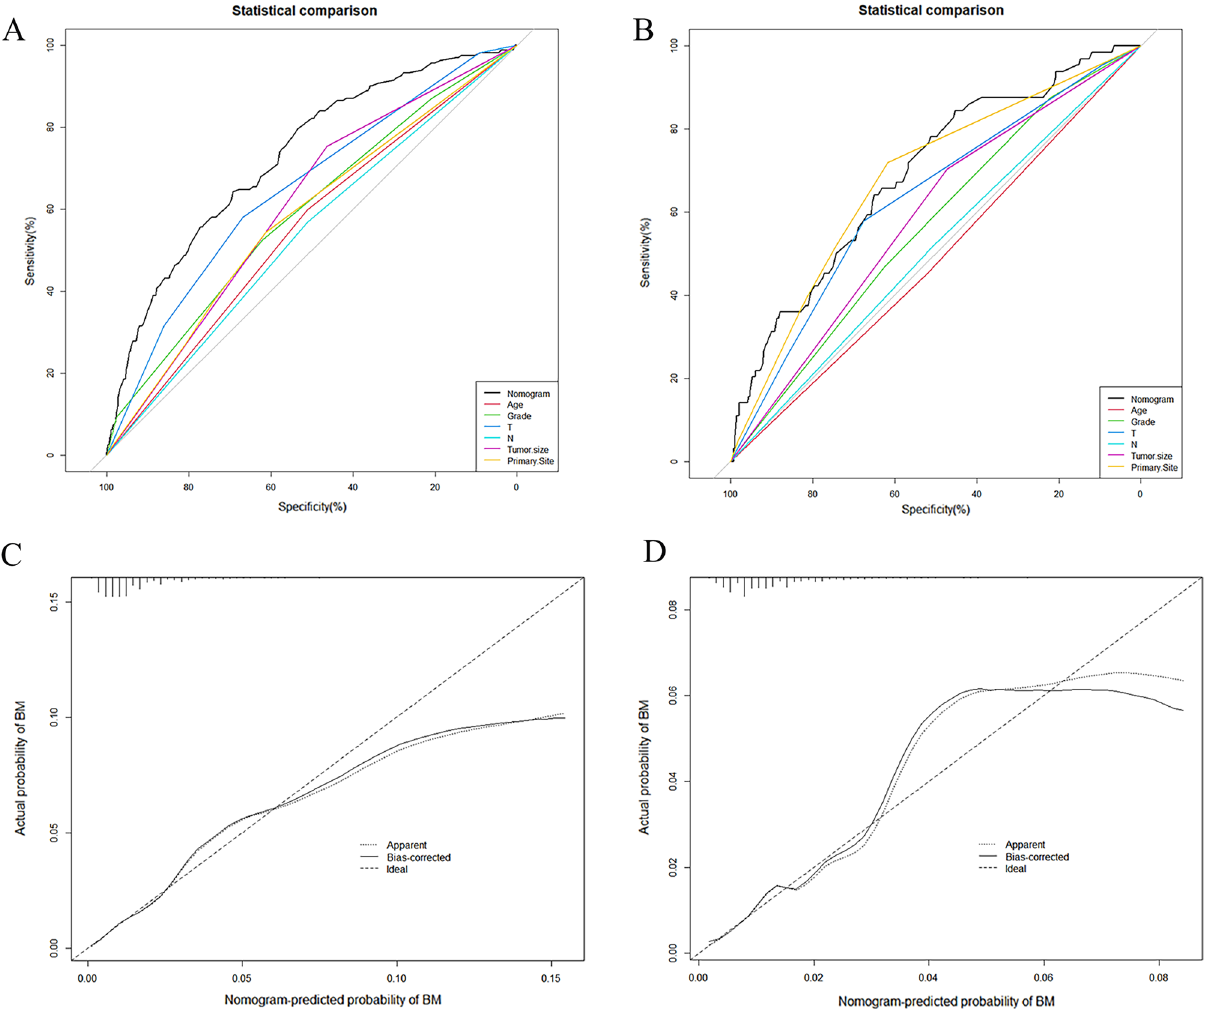
Figure.2:. Comparison of the values of area under the curve between nomogram and single independent risk factors in the training set ( A ) and validation set ( B ); The calibration curve of nomogram in the training set ( C ) and validation set ( D ).